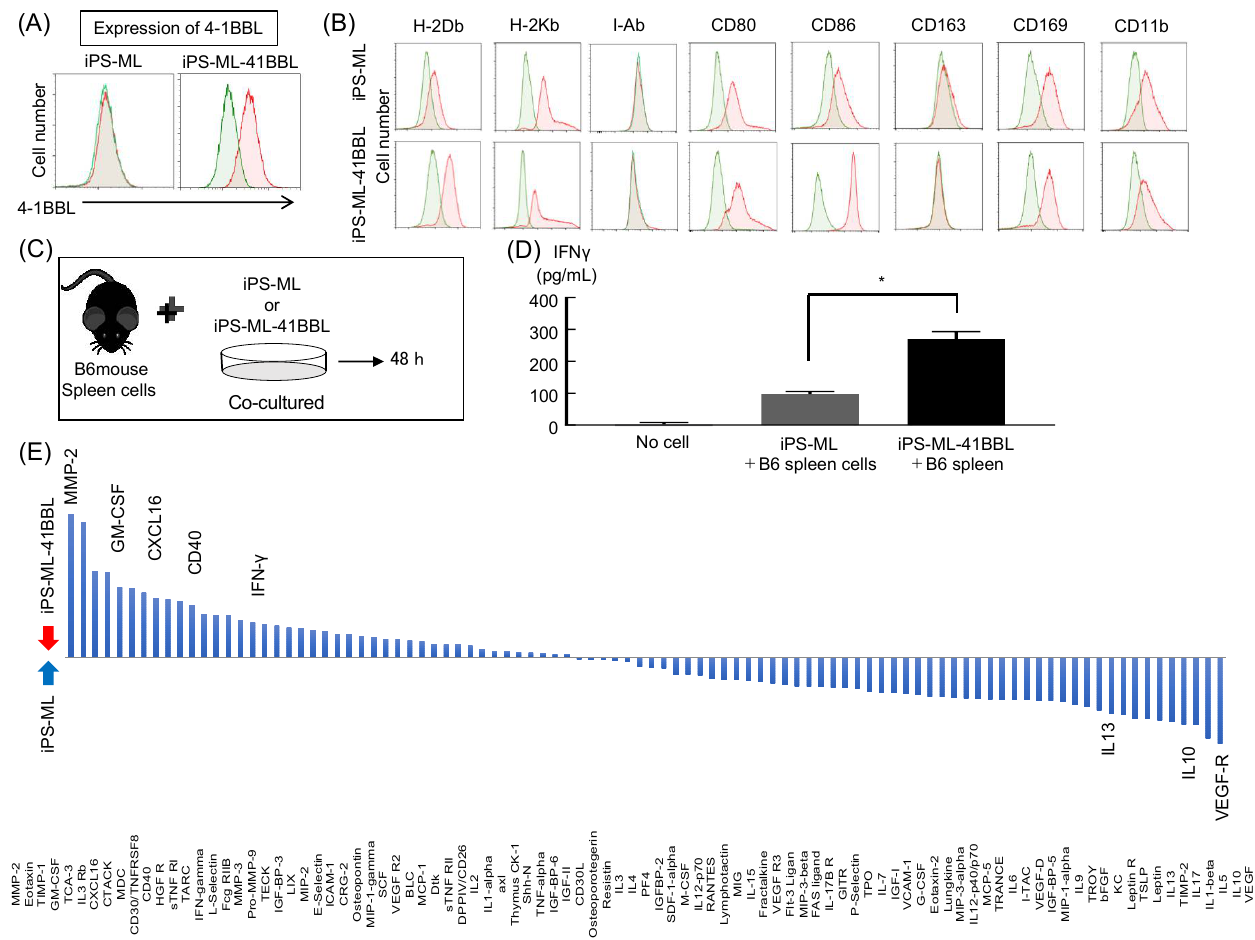
Figure 1. Generation of 4-1BBL-expressing iPS-ML (iPS-ML-41BBL). ( A ) Flow cytometry analysis of the expression of the cell surface molecule, 4-1BBL. The staining profiles of an isotype-matched control mAb (green lines) and the 4-1BBL mAb (red lines). ( B ) Flow cytometry for the expression of the cell surface molecules—HLA class I (H-2Db, H-2Kb), class II (I-Ab), co-stimulatory molecules (CD80, CD86,), and macrophage and dendritic cell markers (CD163, CD169, CD11b) on iPS-ML and iPS-ML-41BBL. The staining profiles of an isotype-matched control mAb (green lines) and the 4-1BBL mAb (red lines). ( C ) The model of sampling schedule for IFNγ ELISA and cytokine array. ( D ) Effects of iPS-ML expressing IFNγ on no cells, iPS- ML, and iPS-ML-41BBL. Expression of IFNγ was analyzed using ELISA. ( E ) Relative expression levels (iPS-ML-41BBL/iPS-ML) of 96 cytokines in the supernatants from cocultured B6 mouse spleen cells and iPS-ML or iPS-ML-41BBL. * p < 0.05.